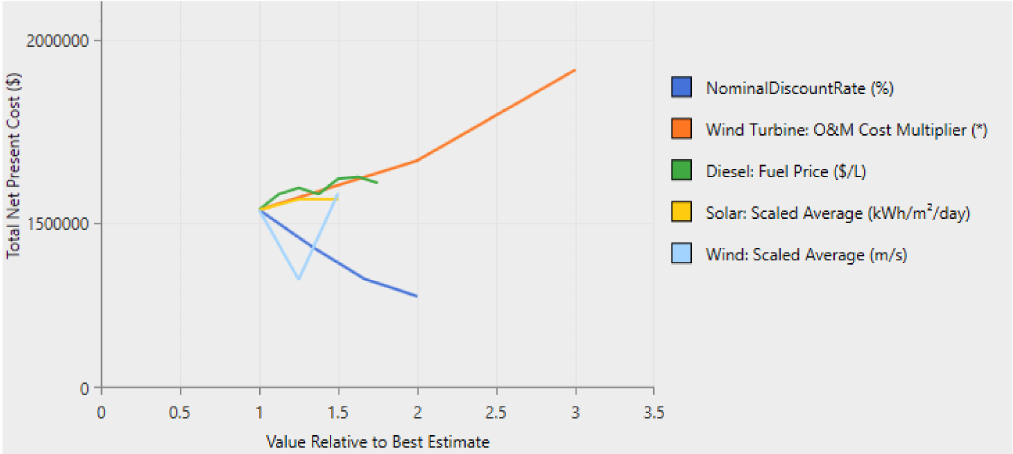
Figure 12. The spider graph of five sensitive